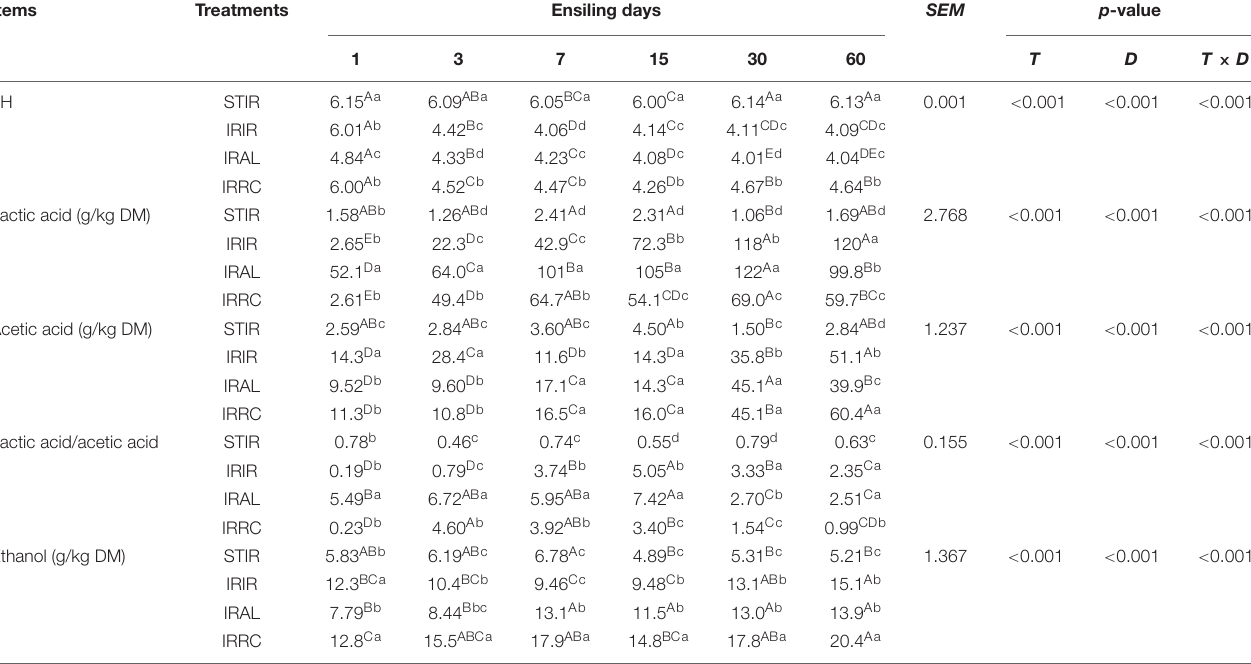
TABLE 2 | Effects of exogenous microbiota on pH, organic acid, and ethanol contents in Italian ryegrass silages. Items Treatments Ensiling days